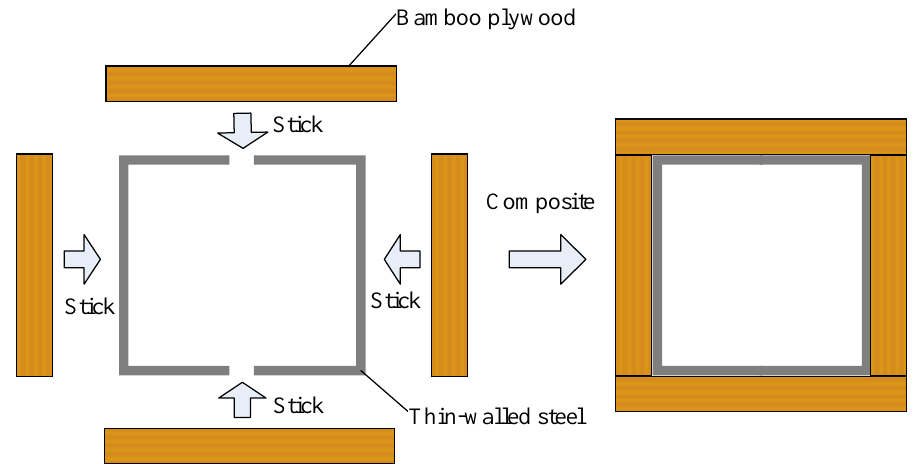
Figure 1. Section of composite column.